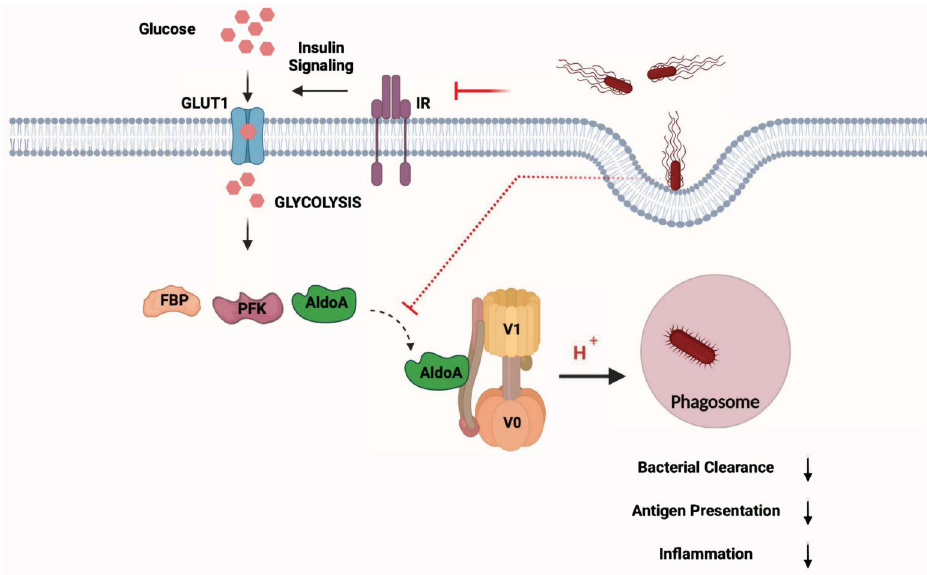
Fig 7. Schematic representation of S. Typhimurium-mediated evasion of phagosome degradation in macrophages by preventing glycolysis-regulated assembly of the v-ATPase.